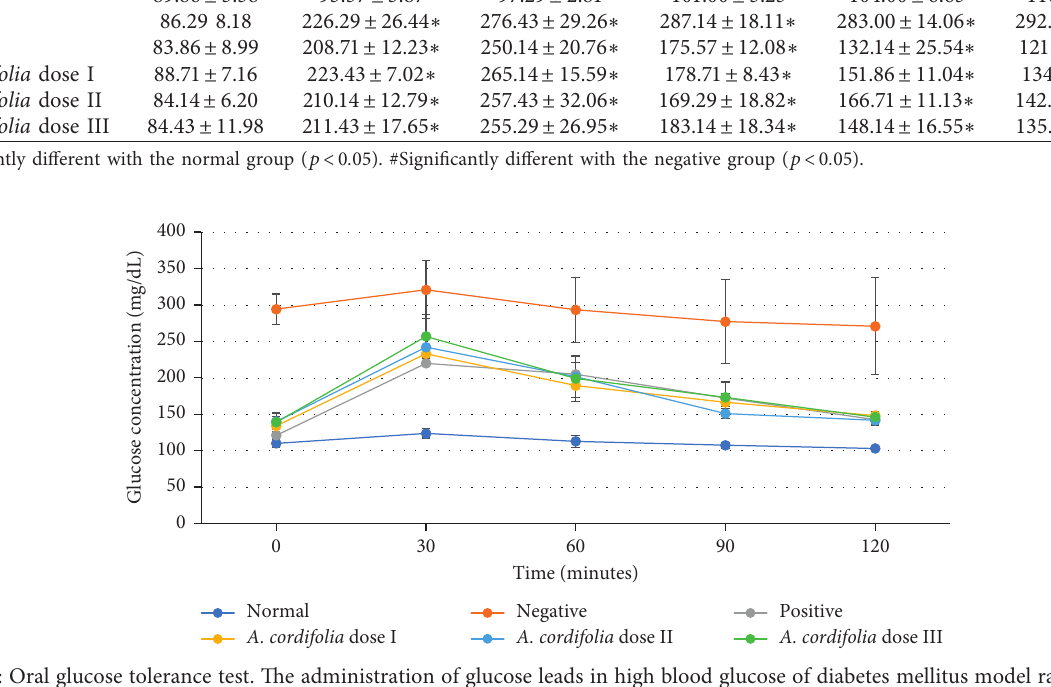
Table 3: Levels of glucose in experimental rats after 21, 28, 35, 42, and 49 days of treatment. Groups